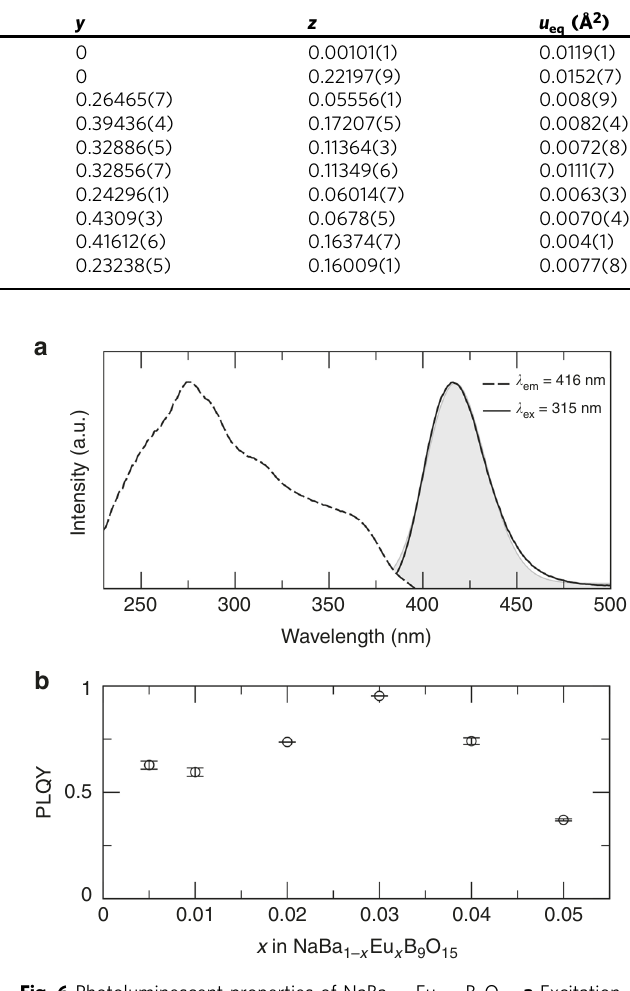
Fig. 6 Photoluminescent properties of NaBa 0.97 Eu 0.03 B 9 O 15 . a Excitation (dashed line) and emission (black solid line) spectra measured at room temperature. The Gaussian fi t of the emission spectrum is solid gray. b Measured photoluminescent quantum yield (PLQY) of NaBaB 9 O 15 substituted with varying concentrations of the rare-earth Eu 2 + under 315 nm excitation. PLQY for each concentration was measured three times and the error bar represents the standard